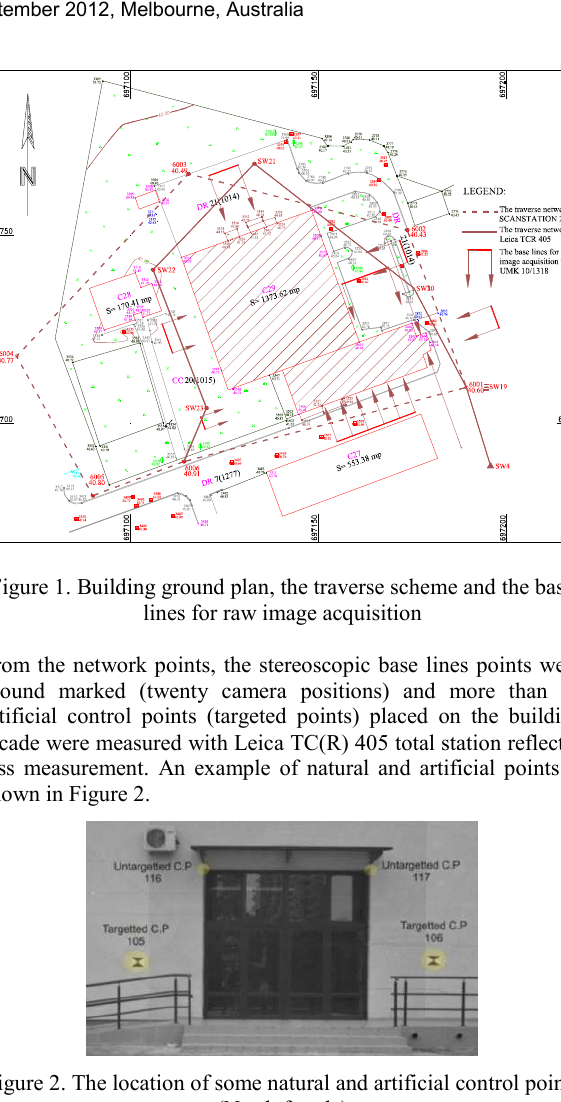
Figure 2. The location of some natural and artificial control points (North facade) The measurement processing made for the control points, were performed with the TopoSys software, resulting the (X, Y, Z) co- ordinates, with a precision of millimeter in all three coordinates, in National Projection System „Stereographical secant plan-1970” and the „Black Sea 1975” reference system for heights. The co-ordinates of some control points, natural and artificial, located on the north facade are presented in Table 1.